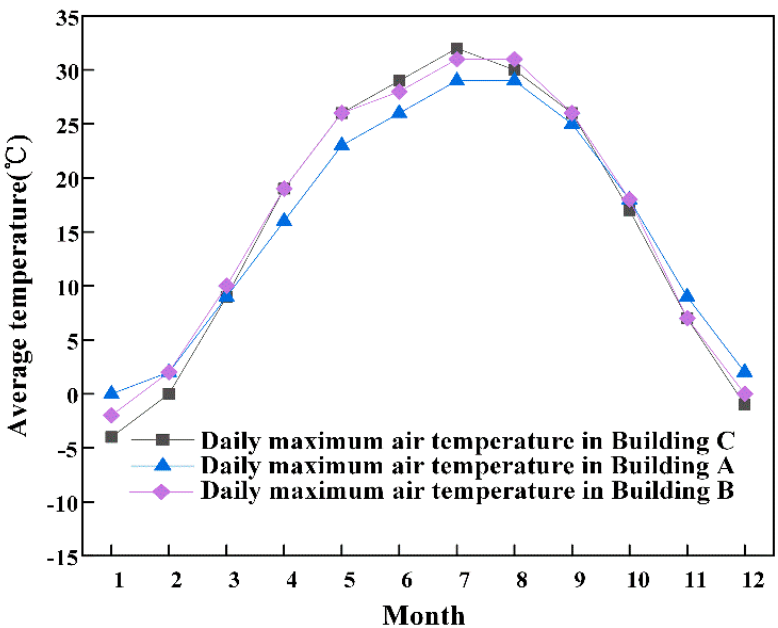
Table 1. Basic information for Buildings A, B, and C.